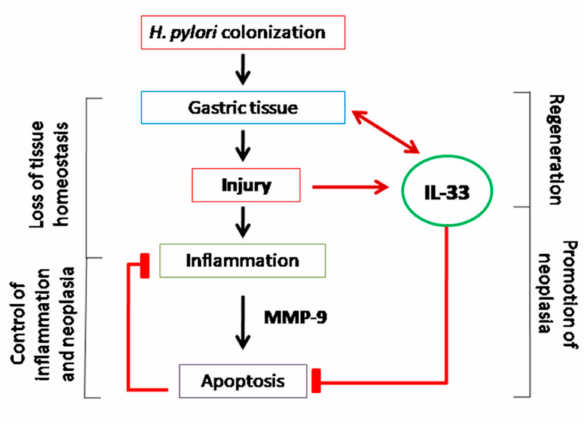
Figure 7. Possible mechanisms of IL-33 in H. pylori- induced